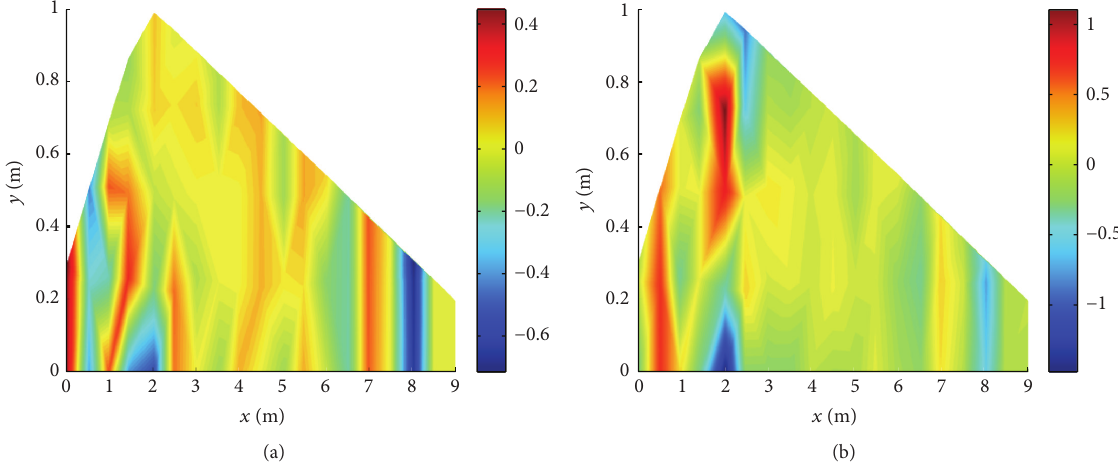
Figure 8: Comparison of damage maps 𝐽 for 5% damage using (a) strain along the 𝑥 -axis only and (b) strain along the 𝑦 -axis only.